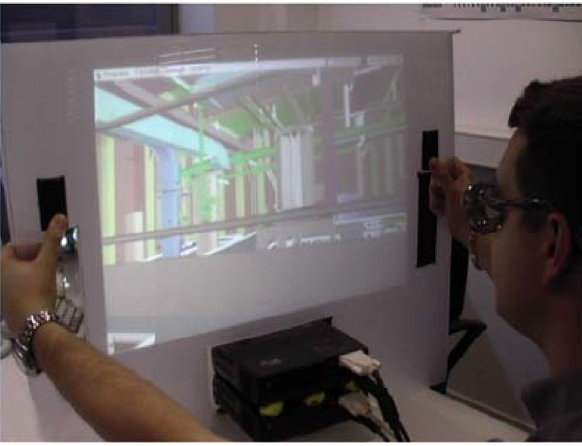
Fig. 1. The miniVR: a portable virtual reality device.